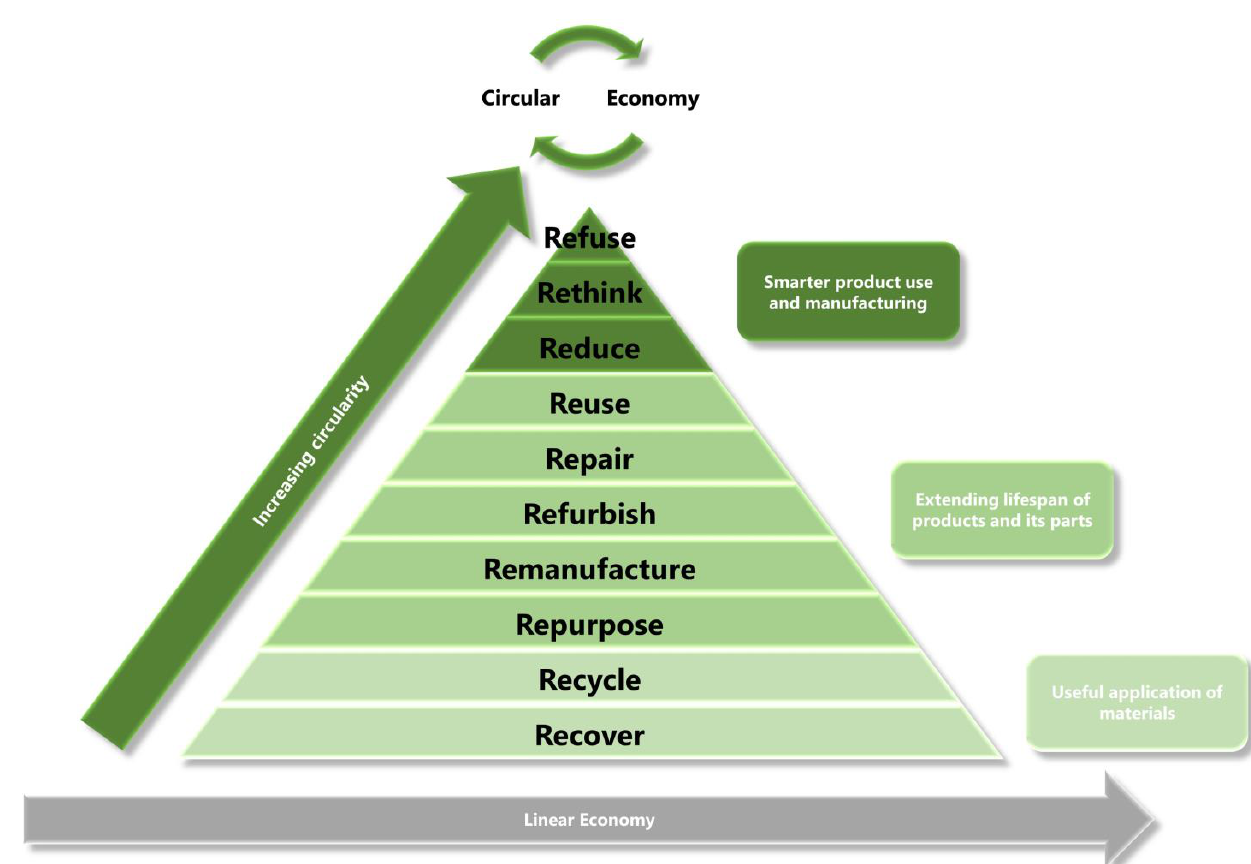
Figure 1. A general view of the desired transition from a linear economy to a circular economy.